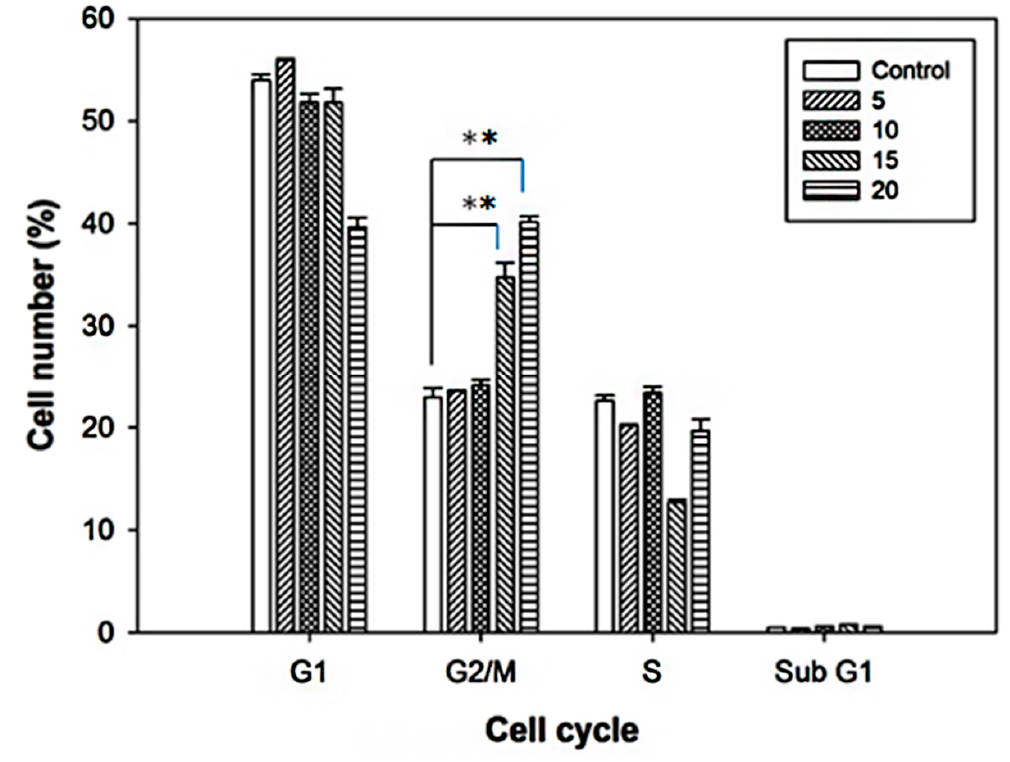
Figure 2. Cell cycle analysis of F98 cells treated with curcumin. F98 cells are treated with various concentrations of curcumin (0, 5, 10, 15, and 20 µ M) for 24 h, and then assayed with flow cytometer. The cells were arrested significantly at G2/M phases. ** p < 0.01.